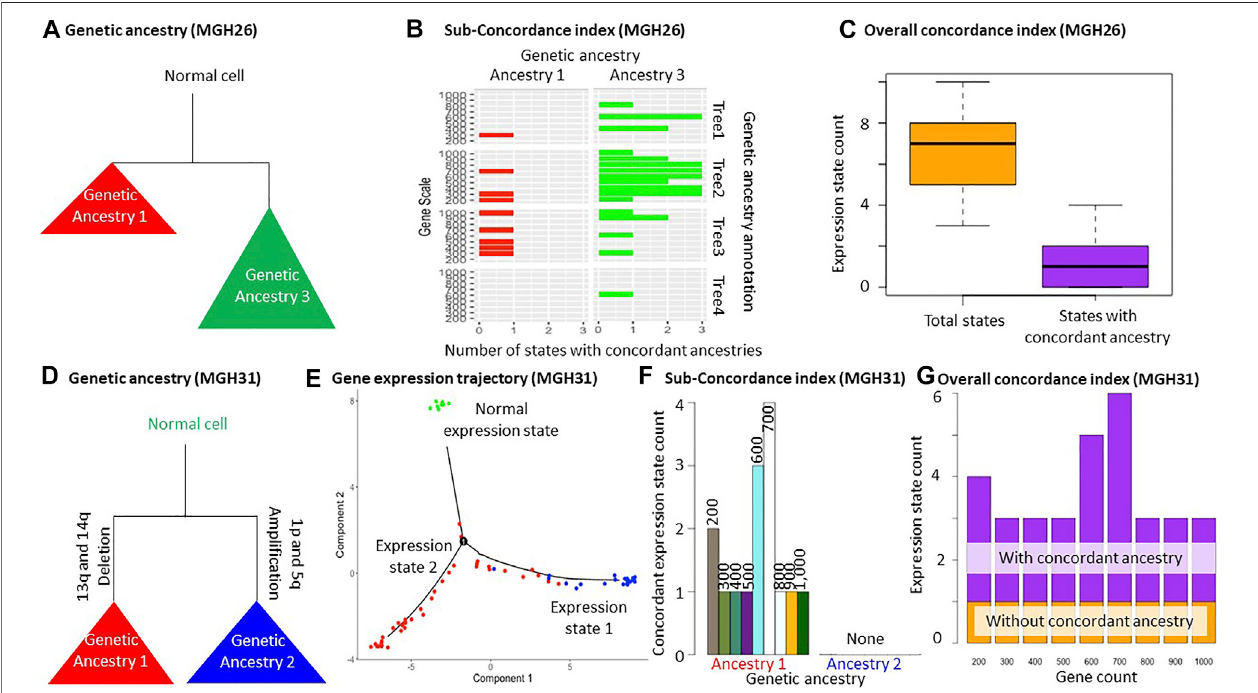
FIGURE 3 | Glioblastoma tumor data analysis. (A – C) Analysis of MGH26 tumor data. (A) Schematic of genetic ancestries that are consistent across four phylogenies ( Supplementary Figure S2 ). (B) Sub-concordance index ( SCI ) of genetic ancestry 1 and 3. (C) The number of all expression states and states that are unique to genetic ancestries allowing a few exceptions ( > 80% of cells from an ancestry share the same expression state). (D – G) Analysis of MGH31 tumor dataset. (D) Schematic of genetic ancestries. Copy number aberrations were used for genetic ancestry annotation for MGH31 data. Cells of genetic ancestry 1 contained 13q and 14q deletion, while cells of genetic ancestry 2 contained 1p and 5q ampli fi cation. (E) The inferred expression trajectory using the top 1,000 most differentially expressed genesbetweenthegeneticancestries.Allnormalcellswerepredicted tohavethesame geneexpressionstate. (F) The Sub-concordanceindex ( SCI )ofeach genetic ancestry. Normal cells were excluded, which always had a concordance index equal to one. (G) The Overall concordance index ( OCI ). The expression state for normal cells was included. The MGH26 and MGH31 datasets are from Patel et al. (2014).